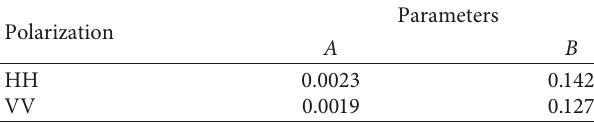
Table 4: Vegetation parameters in the water cloud